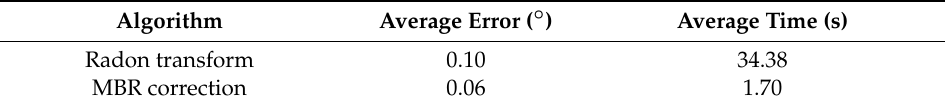
Table 2. Data statistics of nine pictures by 12 × 12.